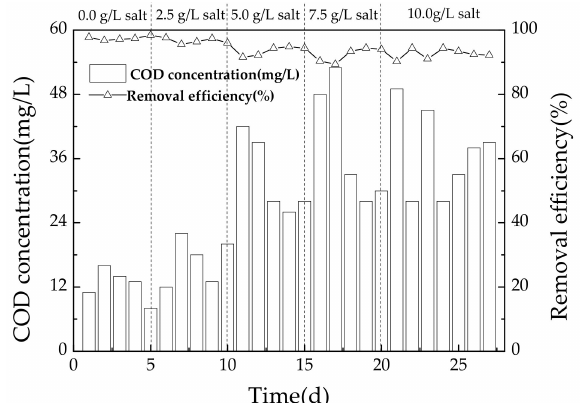
Figure 3. Removal of COD at varying